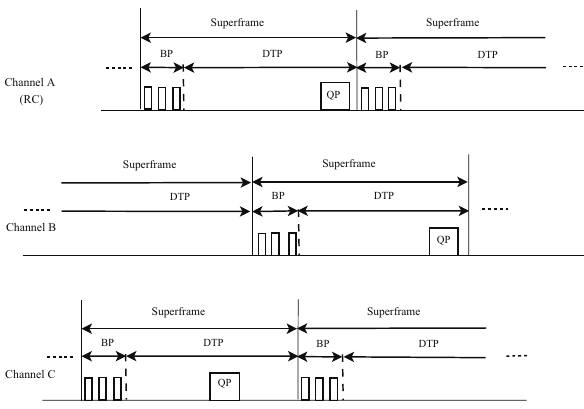
Figure 8. C-MAC superframe structure. RC, Rendezvous Channel; DTP, Data Transfer Period; BP, Beacon